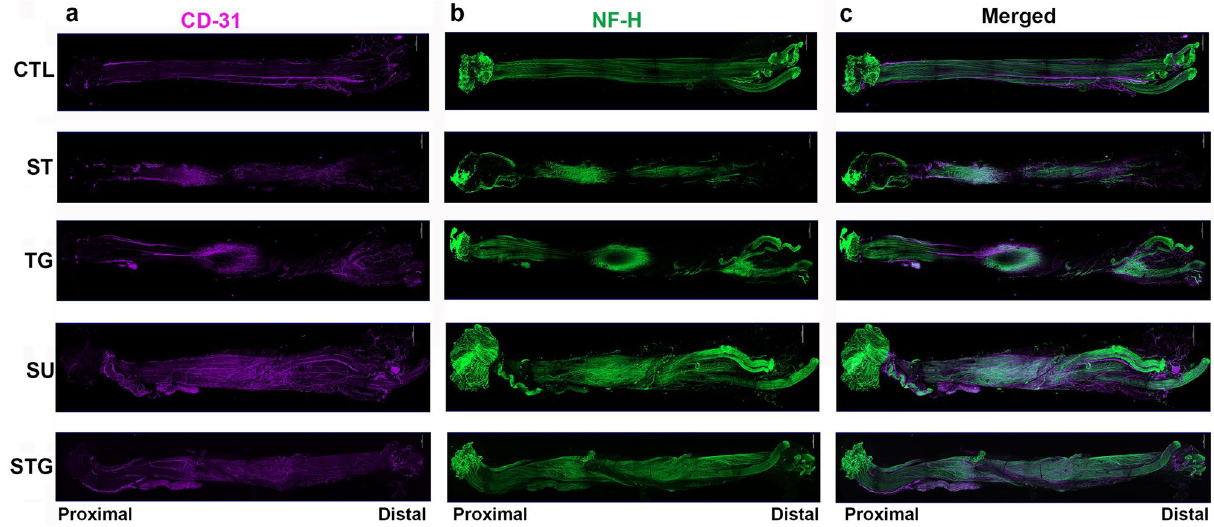
Figure 3. Evaluation of whole mount immunostaining of the transected nerve at post-injury day 28 for angiogenesis. Representative compact images of immunofluorescence staining of the whole nerve for CD31 ( a ) in purple, NF-H ( b ) in green, and the merged view ( c) . Scale bar, 500 µm (at upper right corner); magnification, × 5. For other details, see Fig.